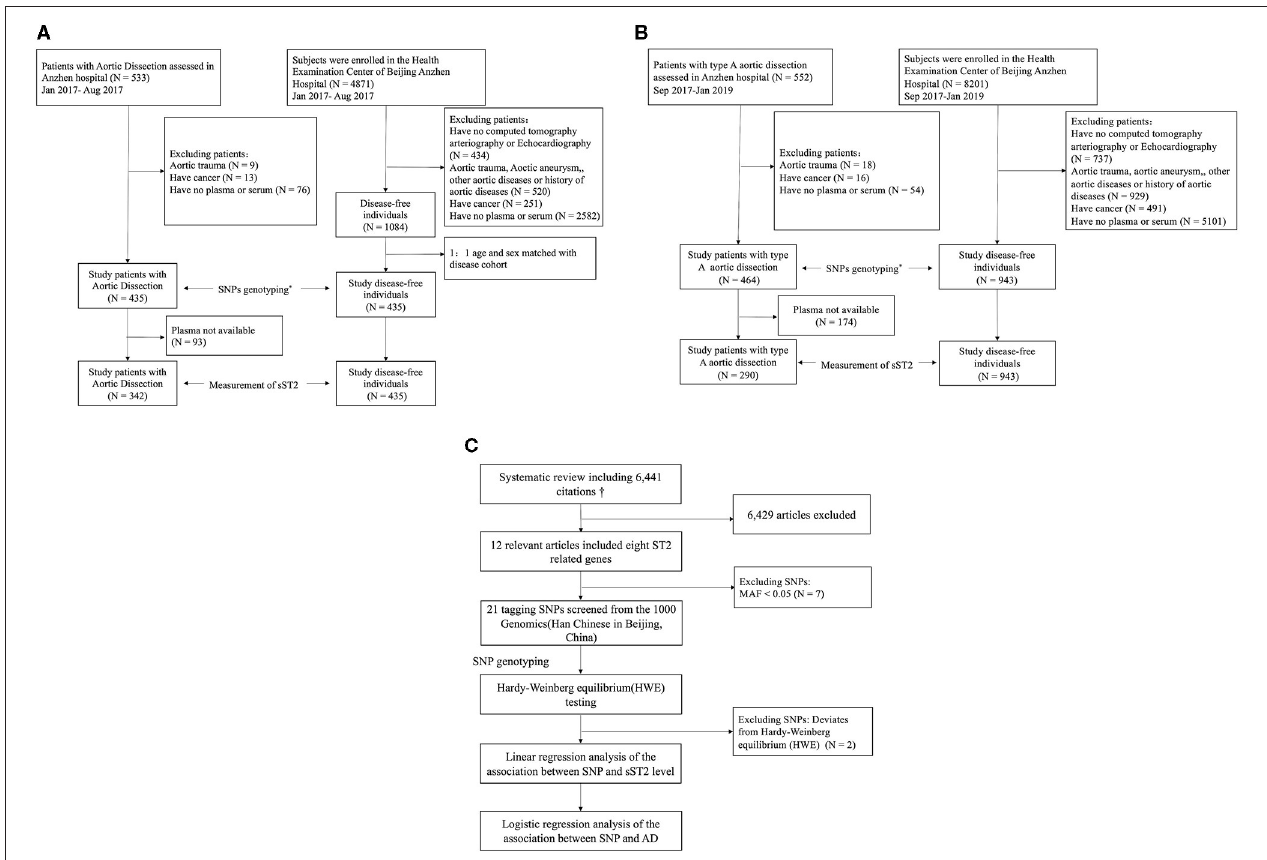
FIGURE 1 | Overall study design. (A) Work flow of the selection subjects for the discovery stage. (B) Work flow of the selection subjects for the validation stage. (C) Selection of tag SNPs. AD, aortic dissection; SNP, single-nucleotide polymorphism. *The SNP screening design is shown in (C) . † See Supplementary Materials for system review